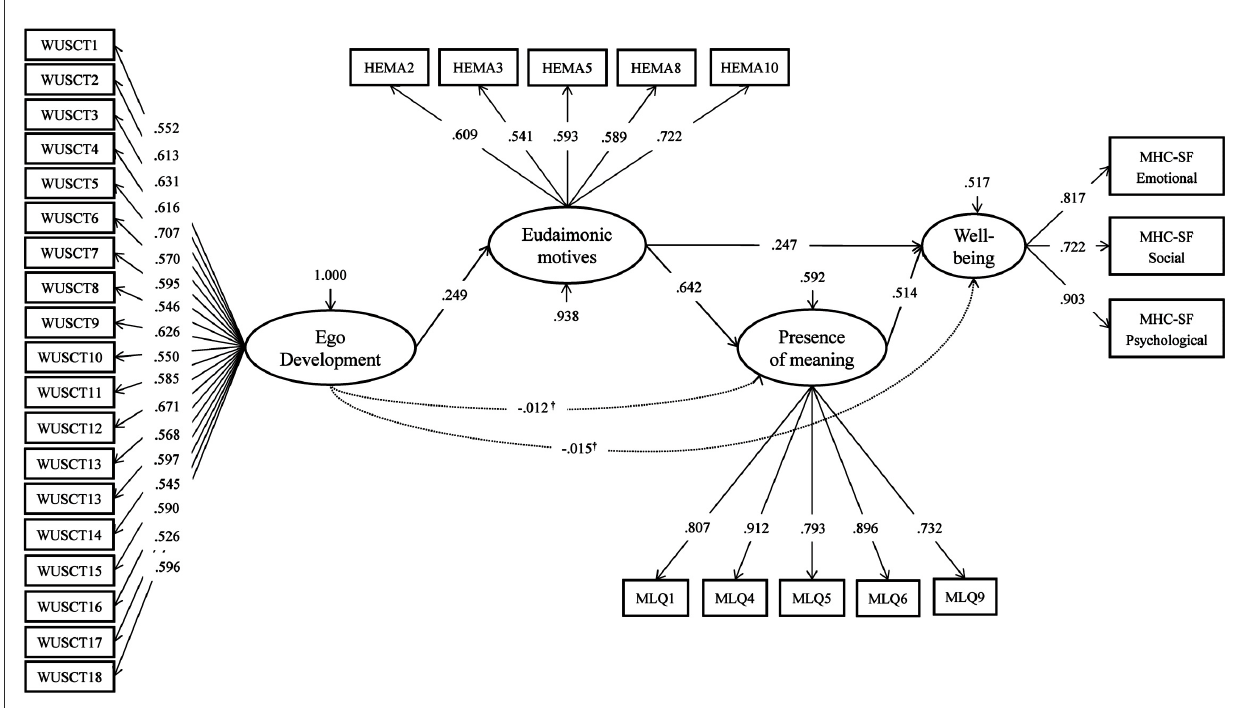
FIGURE2 Parameters of the serial mediation model. χ 2 = 627.22, df = 428, p < 0.001; CFI = 0.973; RMSEA = 0.036, 90% CI (0.030; 0.042); SRMR = 0.048. Standardized coefficients are shown; all the parameters are significant at p < 0.05, except for those marked † .